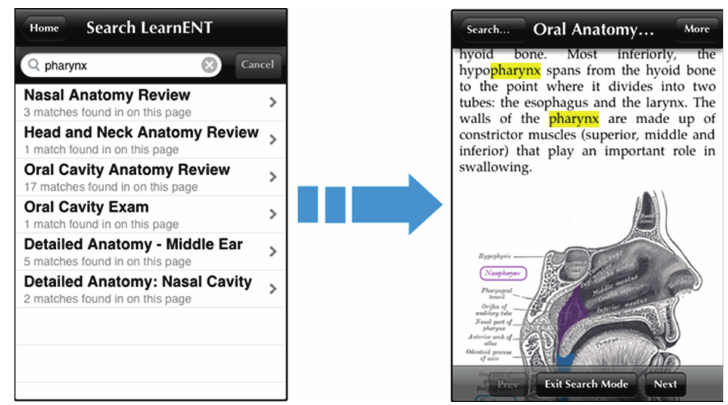
Figure 6: Easily search for key topics using LearnENT’s custom search engine.